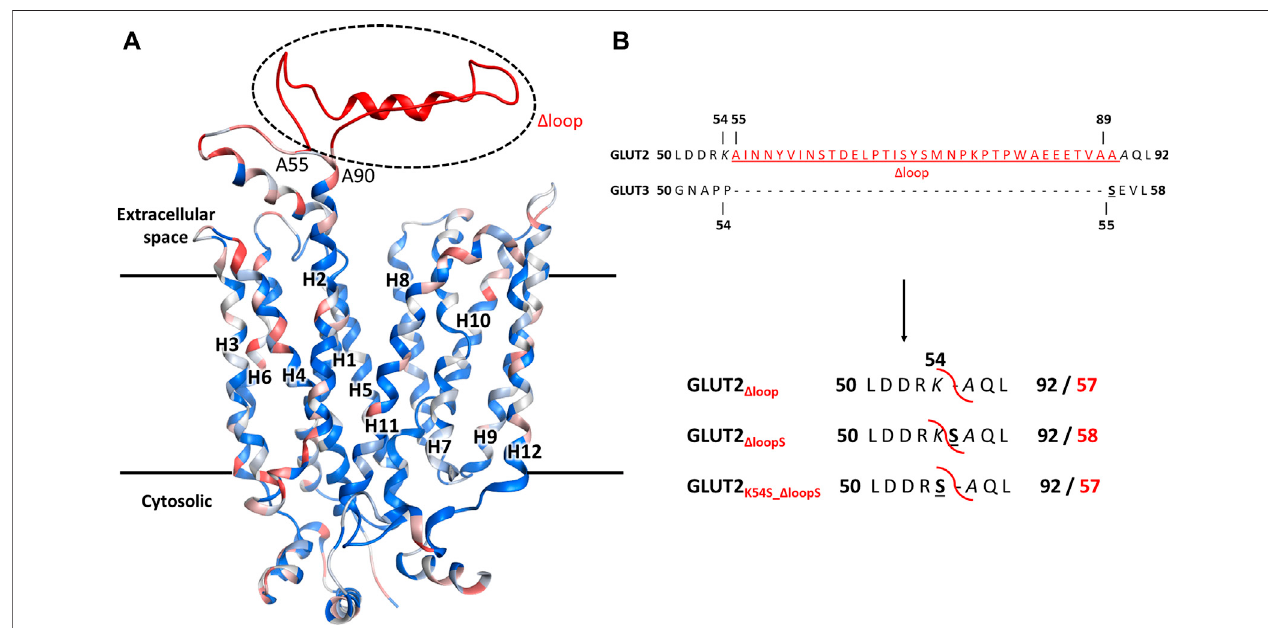
FIGURE2| ThestructuralmodelforGLUT2,GLUT3,andGLUT2constructs. (A) ThestructuralmodelwasgeneratedinMOE,basedonthecrystalstructureofthe outward-facingconformationofhumanGLUT3(PDBID4ZWC).ThecolorcoderepresentsthesequencehomologybetweenGLUT2andGLUT3,rangingfromidentical residues (dark blue) to very dissimilar substitutions (red). Unique to GLUT2 is the extension in the loop between transmembrane helices H1 and H2, in the extracellular space (shown in red). (B) GLUT2 and GLUT3 sequence alignment in the region fl anking the extended extracellular loop of GLUT2 (in red, underlined). The loop deletionconstructsofGLUT2are:GLUT2 Δ loop ,whichlacksresidues55-89,GLUT2 Δ loopS ,whichlacksresidues55-88andhasthemutationA89S,andGLUT2 K54S_ Δ loop , which lacks residues 55-89 and has the mutation K54S. For the two latter constructs, the single substitutions to serine are in analogy to S55 of GLUT3 (black bold underlined). Theredcurvedlineintheconstructs showstheloop excisionsite. FortheGLUT2 constructs, thenumber forboth theoriginal(bold black) andpost-deletion (bold red) sequences are shown.